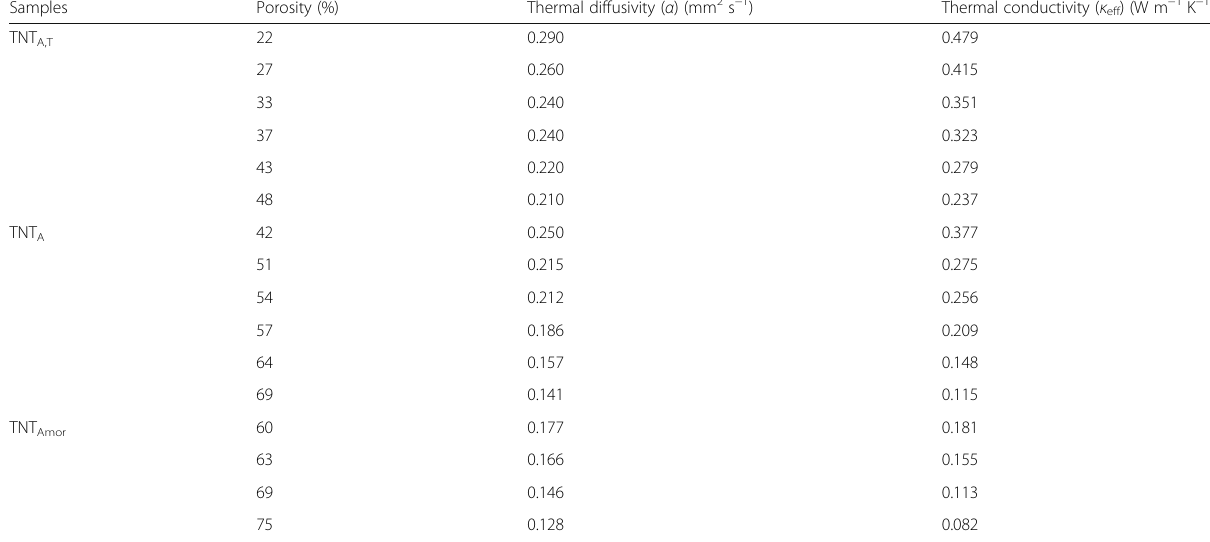
Table 2 The measured thermal properties of the nanotube samples with different porosities Samples